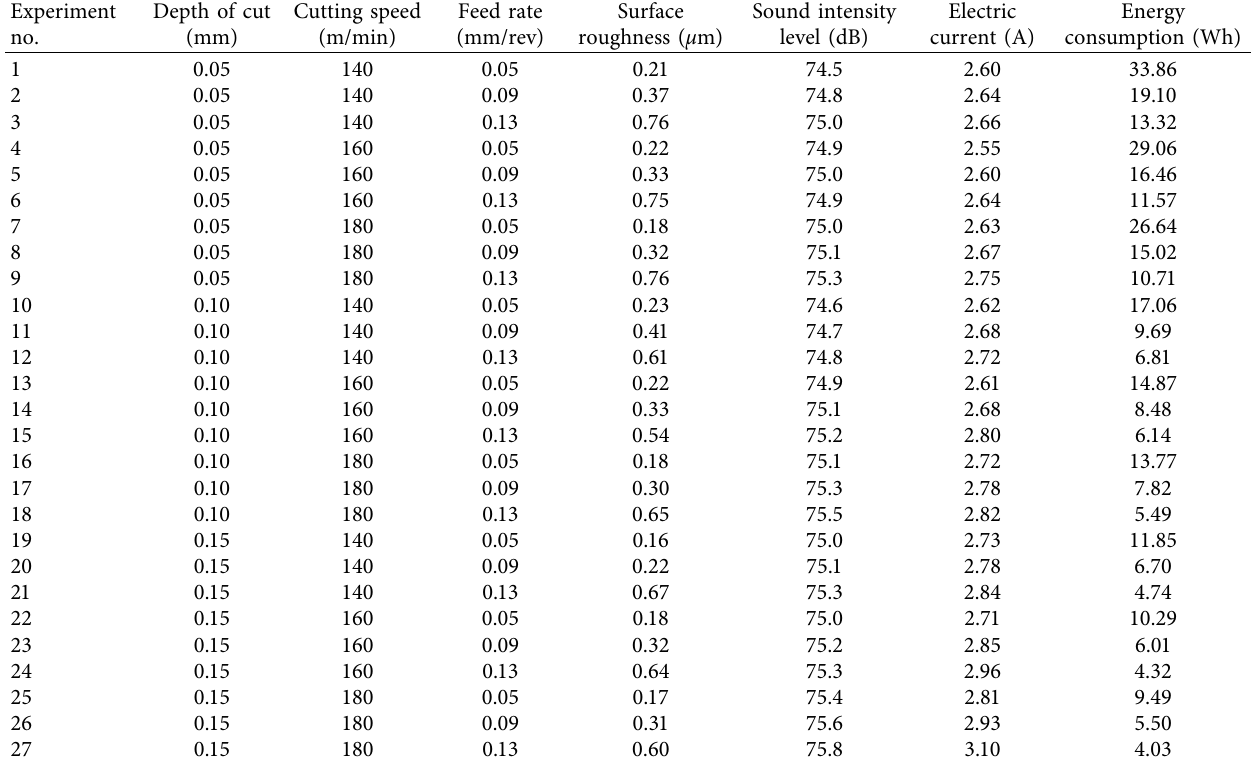
Table 4: Energy consumption calculation results of the whole experiment